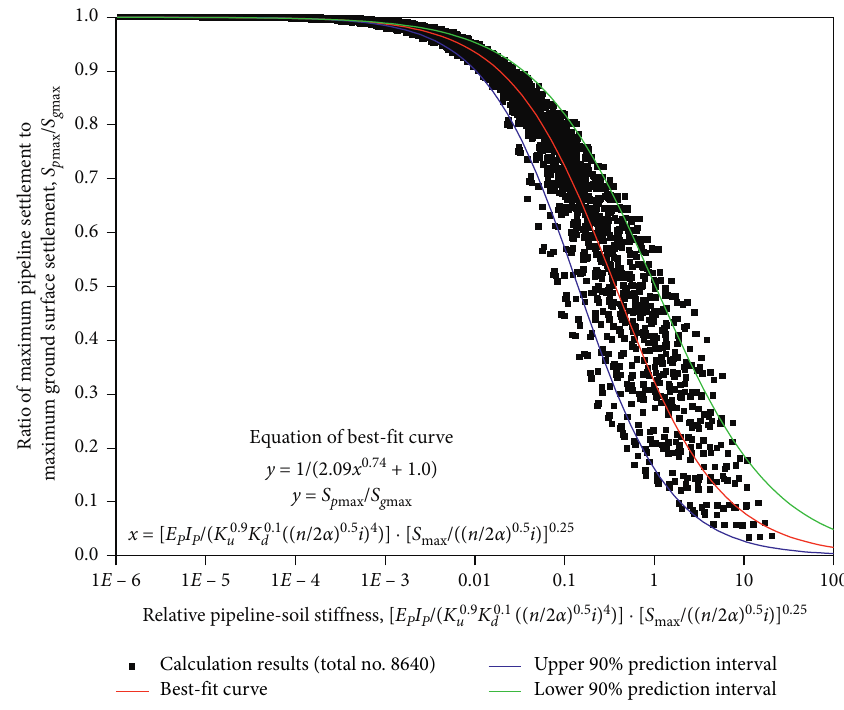
Figure 9: Dimensionless plot of the relative pipeline-soil stiffness versus settlement ratio.